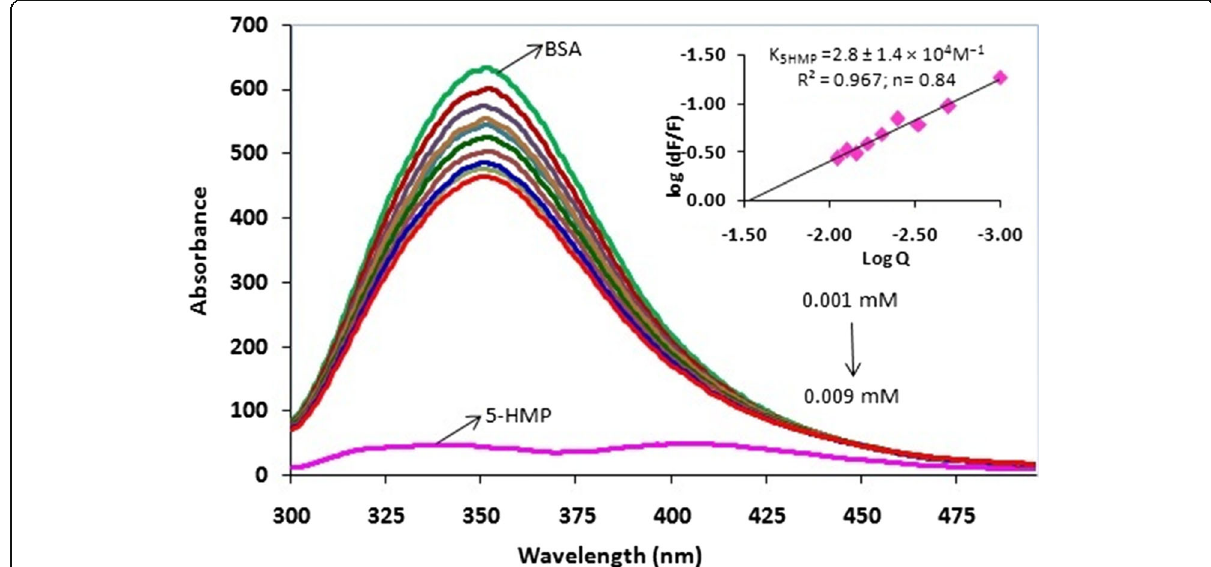
Fig. 5 Fluorescence quenching mechanism spectra of BSA-5-HMP emission under 25 °C, pH 7.4 physiological condition with constant concentration of BSA and increasing concentration of 5-HMP (0.001 – 0.009 mM), inside plot of log (dF/F) against log [Q]